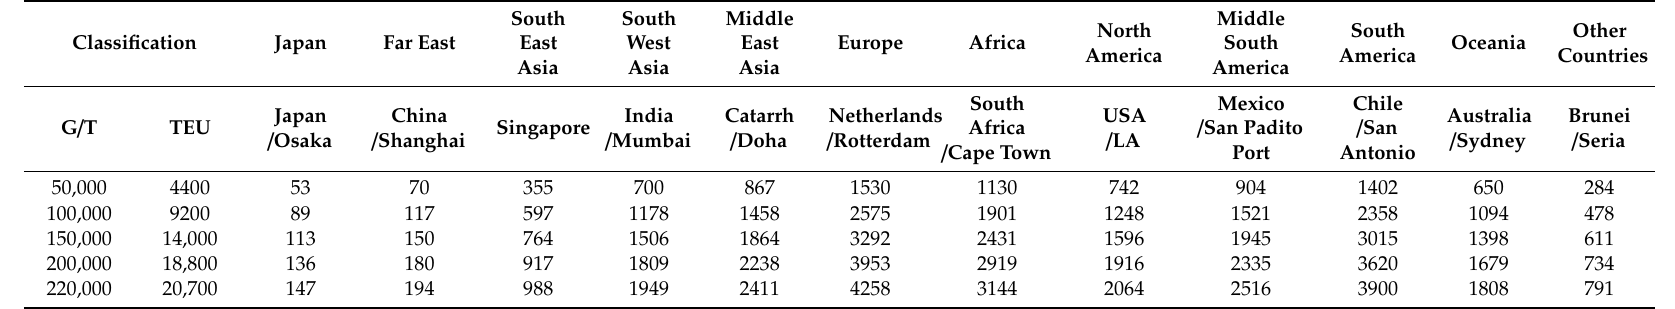
Table A2. LNG Fuel Consumption by Ship Size from Busan Port Origin (Container Ship